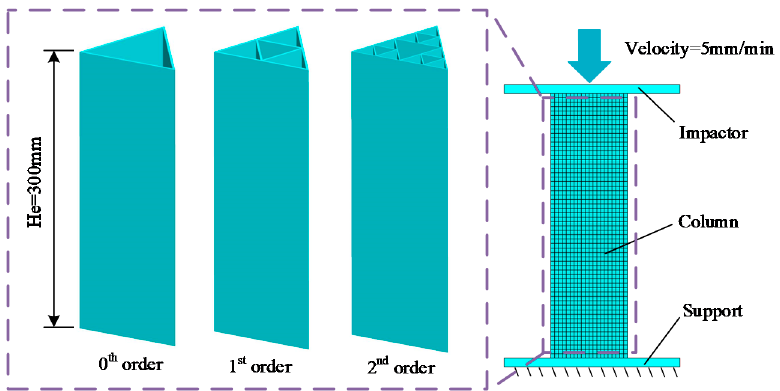
Figure 4. The FE model of the novel fractal structures.